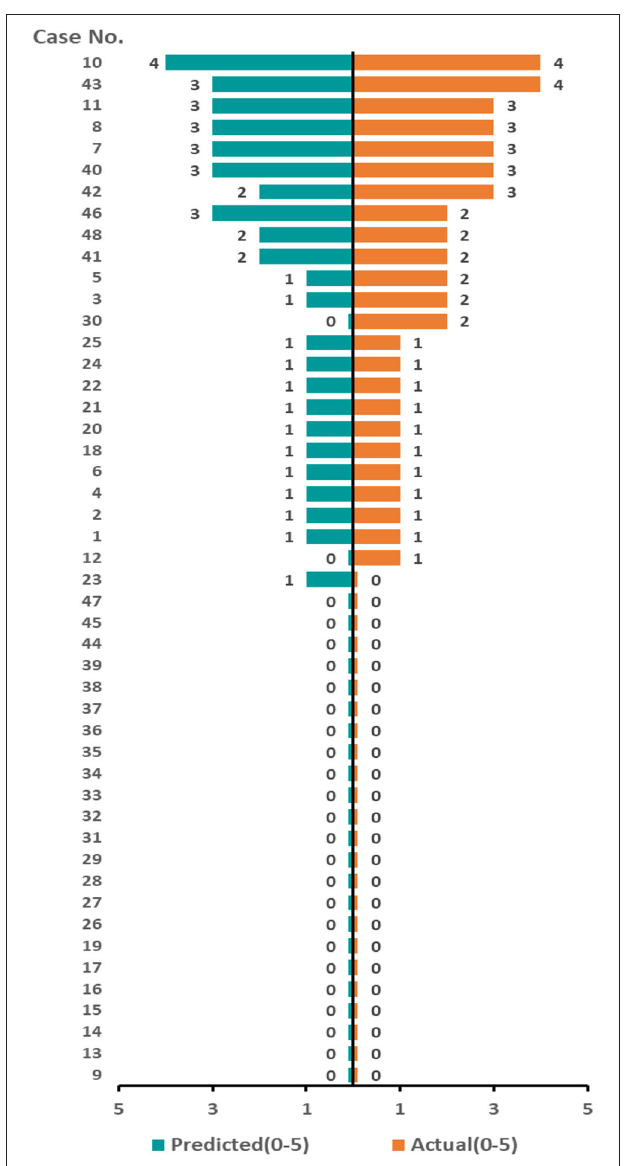
FIGURE 4 | Predicted value for RP compared with the clinical observations according to the RNA sequencing. Each row represents a patient. The predicted results (orange band) correspond to the clinical observation results (blue band) row by row. The length of the band is related to the corresponding RP level. The scores of the predicted or actual observation results are symbolized by the length of each band. The higher the score, the longer the band, indicating a higher level of predicted or observed RP,